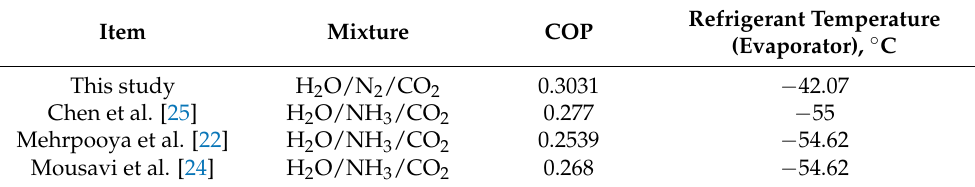
Table A2. Validation of the main parameters of the developed integrated structure.